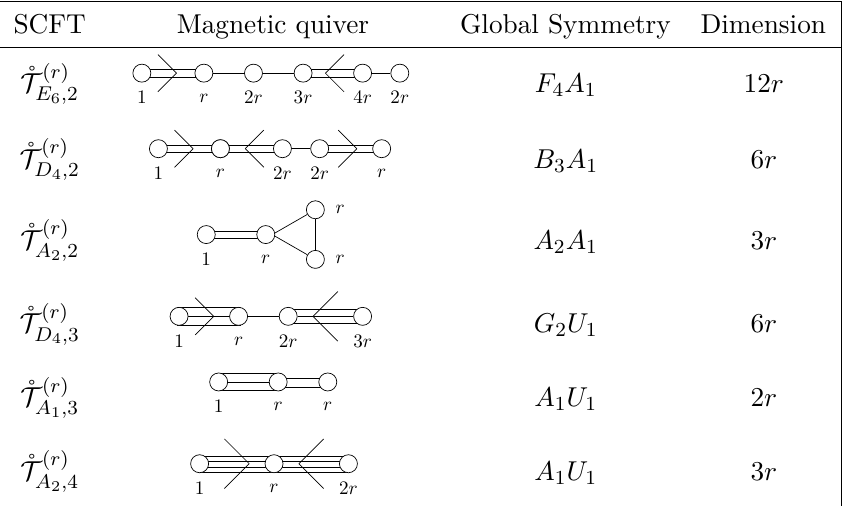
theory. Recall that a G,‘